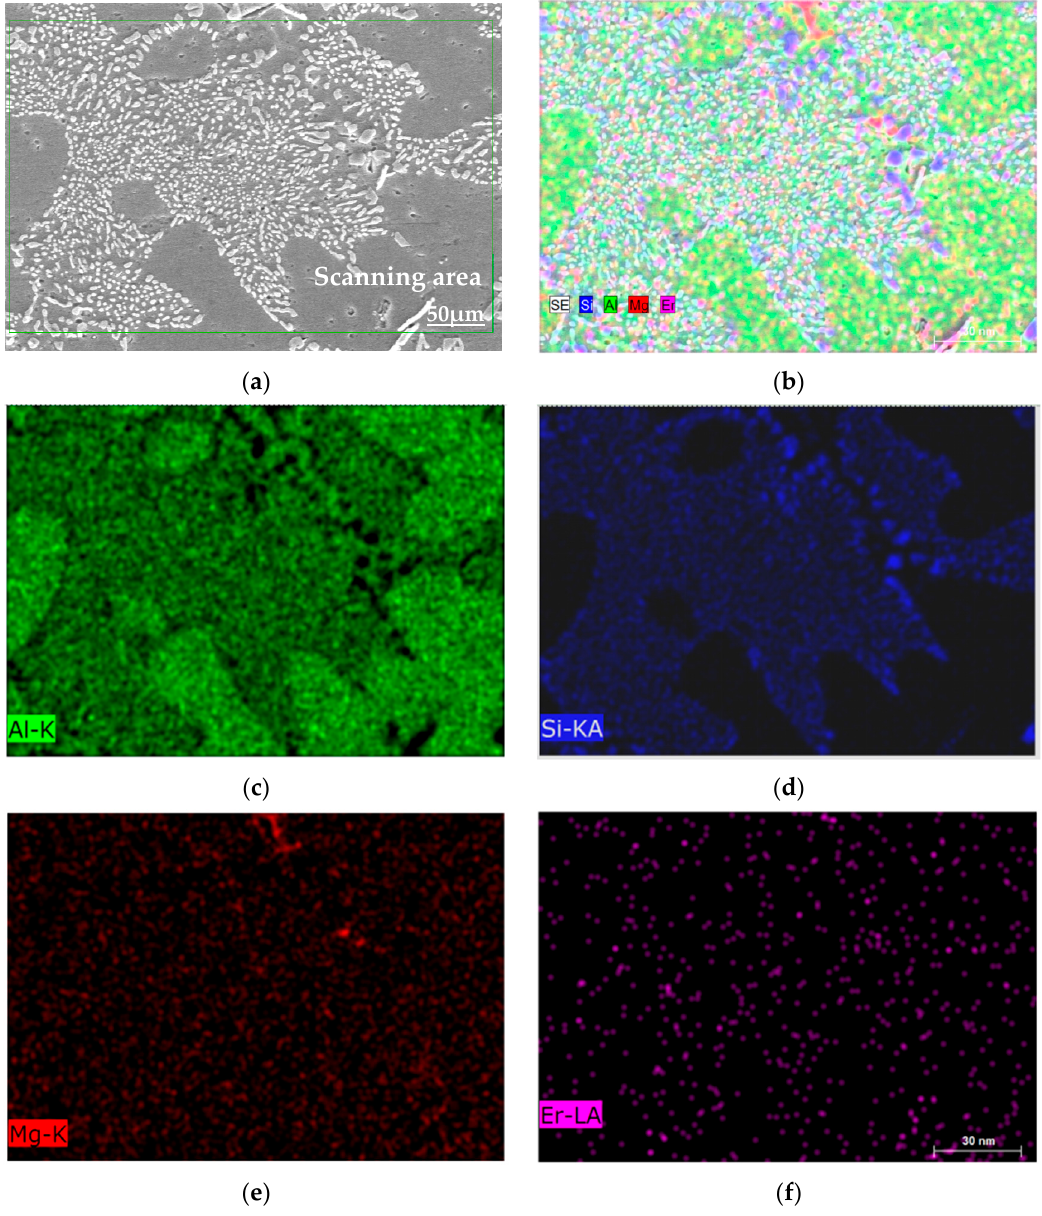
Figure 4. Element distribution analysis of Al-10Si-0.3Mg-0.2Er alloy through EDS: ( a ) Microstructure; ( b ) Overall distribution of Al, Si, Mg, and Er; ( c ) Distribution of Al; ( d ) Distribution of Si; ( e ) Distribution of Mg; ( f ) Distribution of Er.